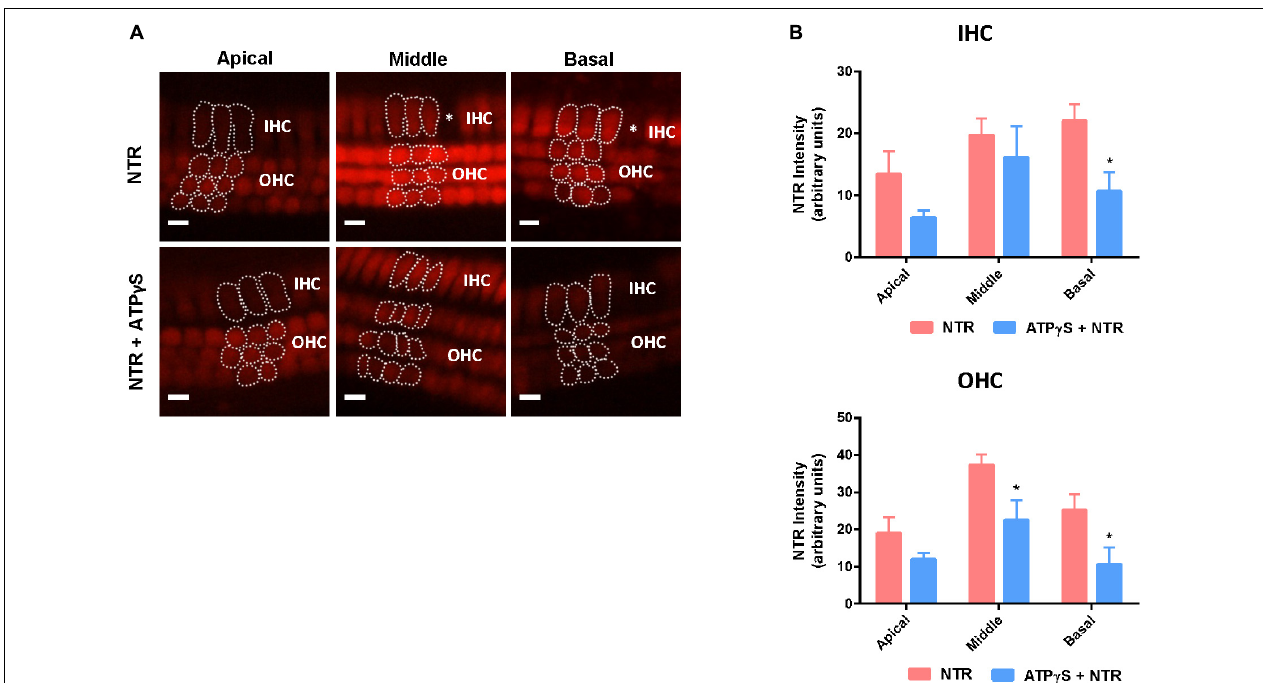
FIGURE 4 | Changes in Neomycin-Texas Red (NTR, 1 mM, 3 h) uptake in the mouse P3 organ of Corti explant after ATP γ S supplementation. (A) NTR labeling in the apical, middle, and basal segments of the cochlea with or without inclusion of ATP γ S. Asterisks, missing hair cells. IHCs, inner hair cells; OHCs, outer hair cells. Scale bars: 10 µ m. (B) NTR pixel intensity quantification. ATP γ S (1 µ M) had no effect on NTR uptake in the apical hair cells, but significantly reduced NTR uptake in the basal segment IHC and middle and basal segment OHC. Data presented as mean ± SEM; NTR, n = 10; NTR + ATP γ S, n = 4. ∗ p < 0.05, one-way ANOVA followed by Tukey’s multiple